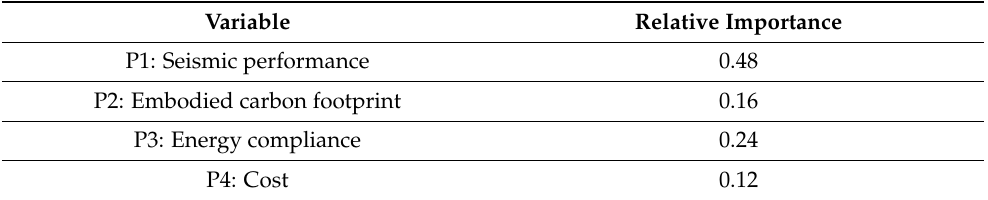
Table 6. Decision variables for the three retrofit alternatives presented in this study.